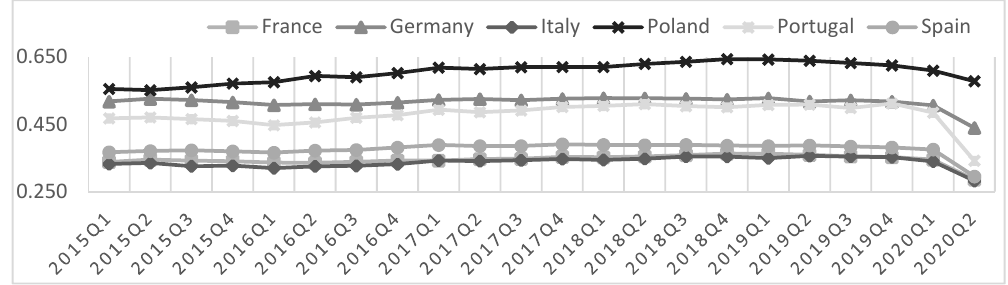
ffi cient of exports in output, own work, source: Figure 3. The coefficient of exports in output, own work, source: Eurostat. Figure 3. The coe